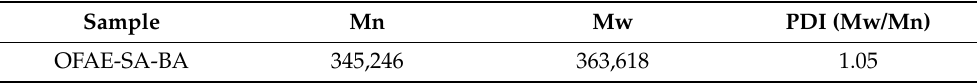
Table 2. GPC testing of OFAE-SA-BA.